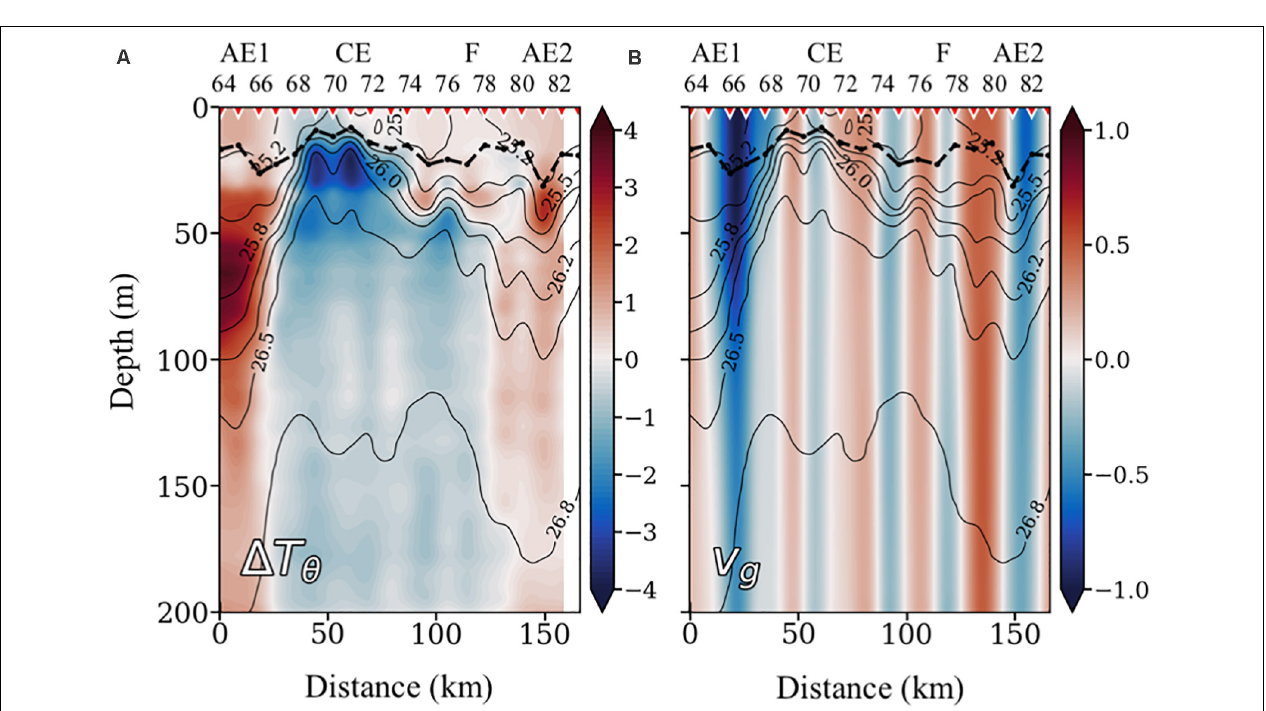
FIGURE 3 | Vertical sections of potential temperature anomaly ( (cid:49) T θ ) in ◦ C (A) and across section geostrophic velocity (V g ), relative to 1,000 dbar, in m · s − 1 (B) , both with the isopycnals superimposed. Inverted red triangles on the top axis indicate stations position. The locations of the anticyclonic eddies (AE), the cyclonic eddy (CE), and the filament (F) are also indicated on the top axis. The bold black line shows the depth of the mixed layer (MLD). In the V g plot, positive values indicate north-westward currents, while negative values indicate south-eastward currents.